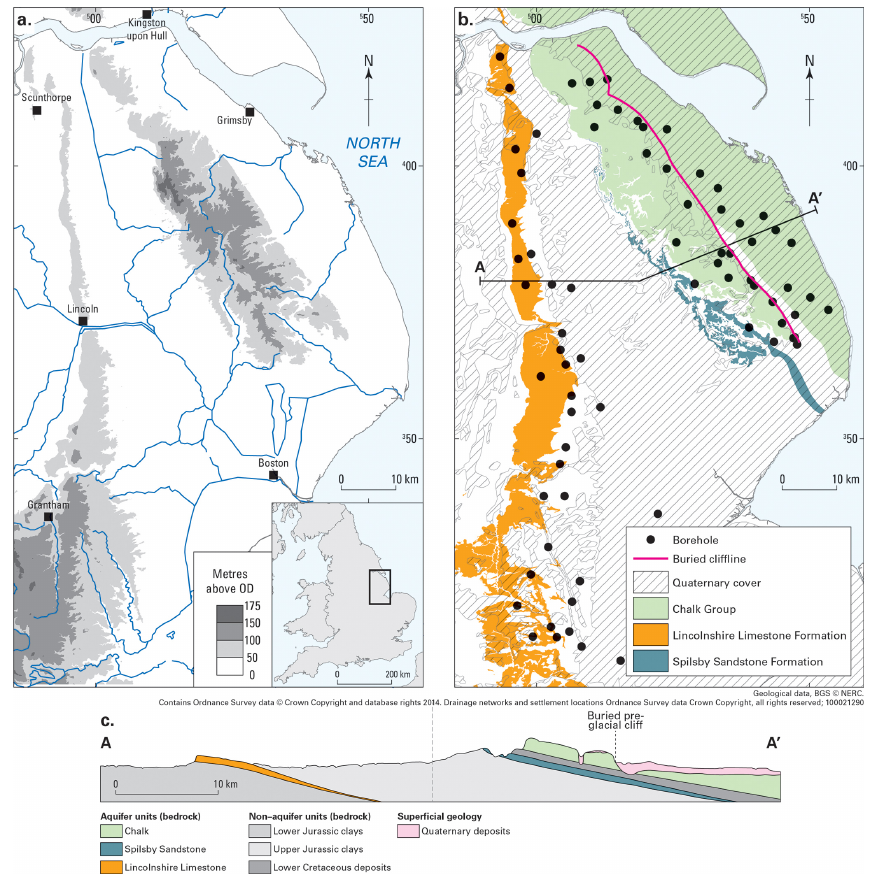
Figure 1. Case study area (left panel) and simplified geology map (right panel) showing locations of the observation boreholes. Cross section (bottom panel) illustrating the stratigraphy–depth relationships between the three major aquifers in the study region: the Lincolnshire Limestone, the Spilsby Sandstone and the